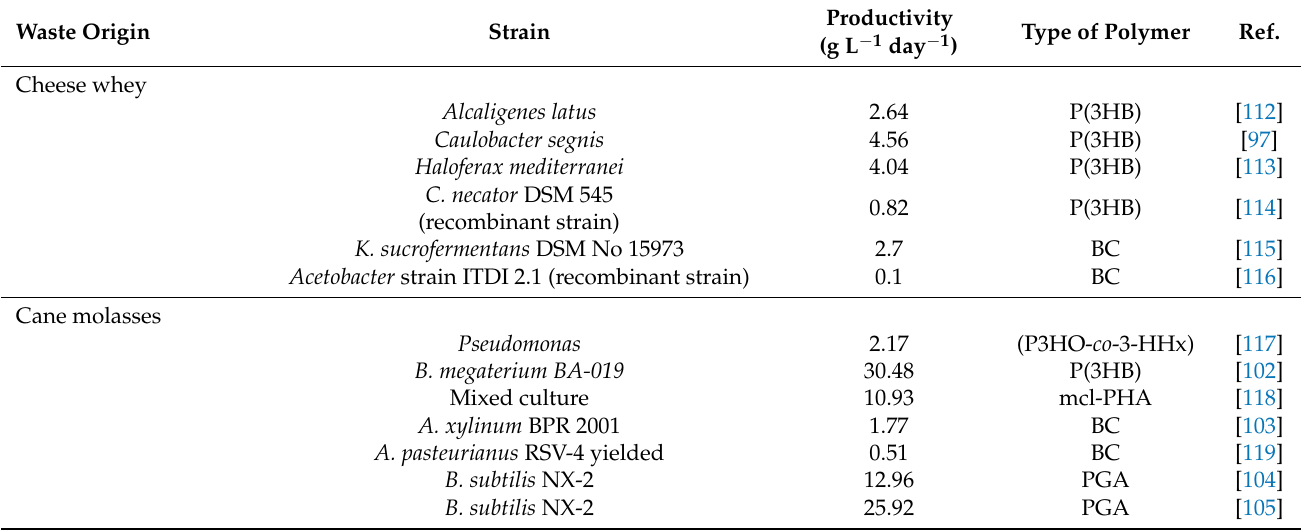
Productivity Type of Polymer Ref. (g L − 1 day − 1 )